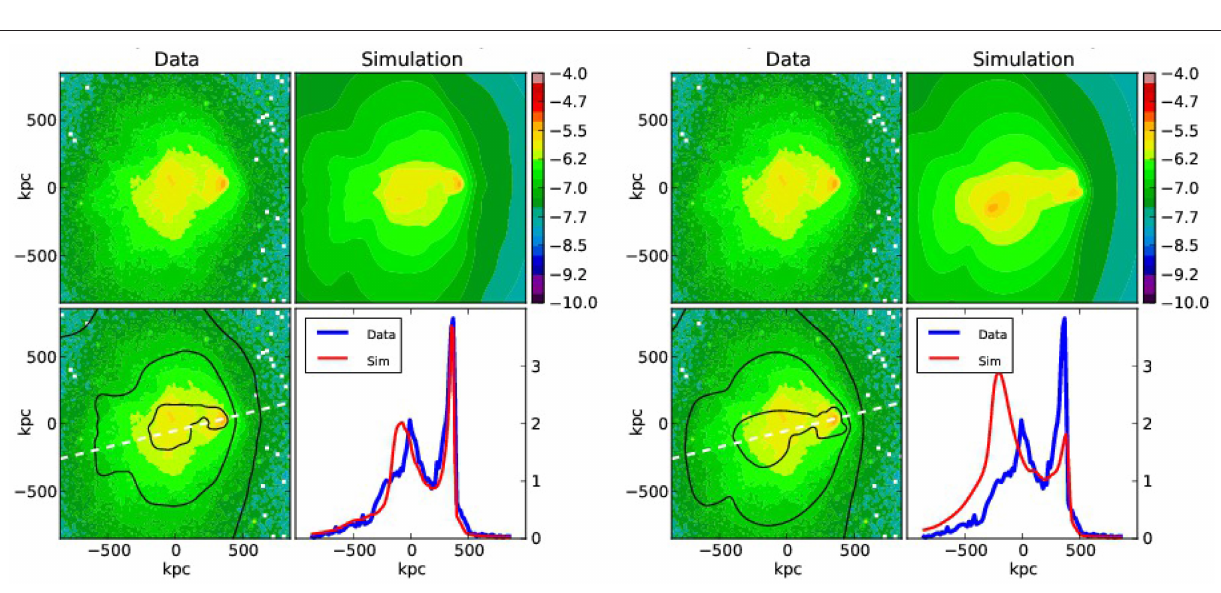
FIGURE 7 | The effect of the ICG magnetic field on the X-ray flux in the range of 0.5–2keV. The peak of the X-ray emission is shifted as a result of magnetic pressure. Left Panel: First row (left and right panels): X-ray surface brightness from data and simulations assuming B 0 = 61 µ G for the amplitude of the magnetic field (note that B ∝ ρ 2 / 3 g was assumed). Second row: left panel: data with contours from simulations over-plot; right panel: X-ray surface brightness along a cut marked as a dashed line on the left panel. Right Panel: Same as left panel but assuming B 0 = 0.01 µ G (from Lage and Farrar,